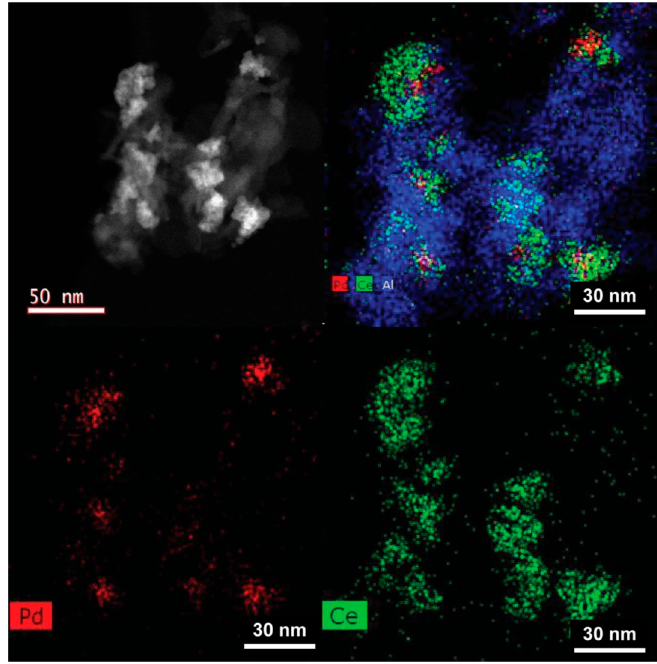
Figure 7. HAADF-STEM image and EDS mapping of 20CeO 2 -4Pd / Al 2 O 3 catalyst (post reaction). ( top left ) STEM image; ( top right ) elementary distribution of Pd, Ce, Al overlapped together; ( bottom left ) EDS mapping to show elementary distribution of Pd; ( bottom right ) EDS mapping to show elementary distribution of Ce. Pd, Ce, and Al are color coded as red, green, and blue, respectively.